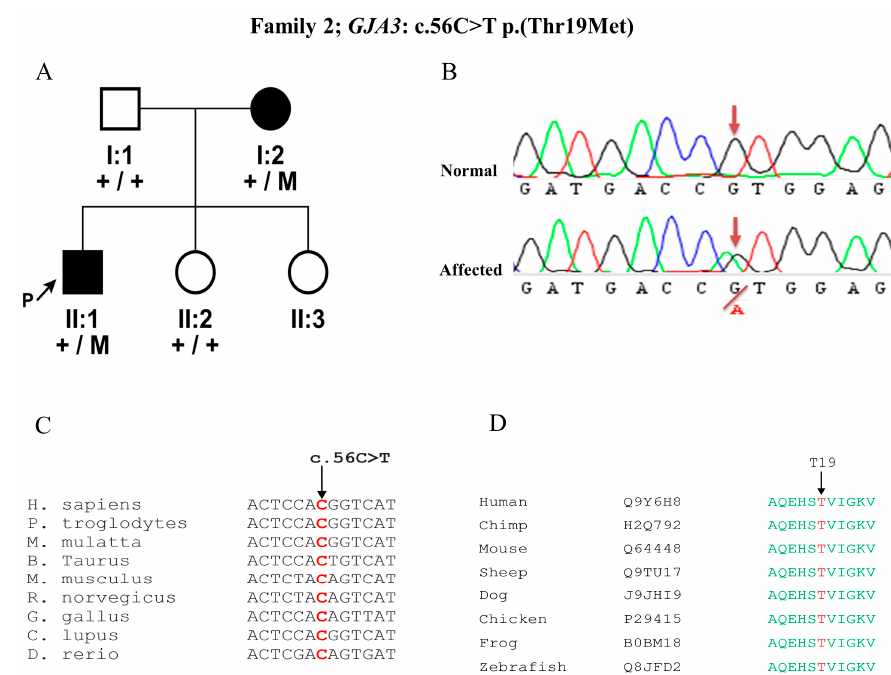
Figure 2. Pedigree of a Family 2 with dominant GJA3 mutation: ( A ) Family with congenital cataract, showing segregation of a mutation c.56C>T p.(Thr19Met) in the GJA3 gene. Normal individuals are represented with +/+ and affected individuals with the +/M symbol for the mutation. ( B ) Sanger sequencing DNA chromatogram of GJA3 for the normal and affected individuals. ( C , D ) Nucleotide and amino acid conservation in orthologous species for the c.56C>T p.(Thr19Met). The wild type nucleotide (C) and amino acid (T) are represented with arrow and in red color.